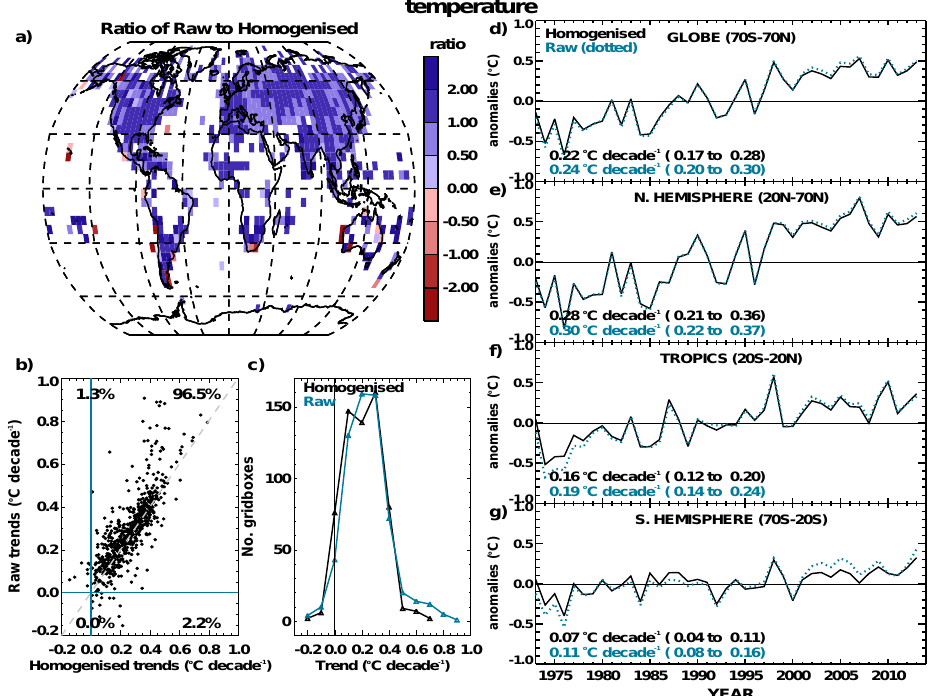
Figure 7. Comparison of decadal trends from 1973–2013 between raw and homogenised monthly mean temperature. (a) Ratio of raw to homogenised trends for each grid box (a value of > 1 means that the raw trend is greater than the homogenised trend). (b) Scatter plot of raw verses homogenised decadal trends for each grid box with percentage presence in each quadrant. (c) Trend size distribution for raw and homogenised grid boxes. (d) Large-scale area-average time series (weighted by the cosine of the latitude) and decadal trends calculated using the median of pairwise slopes with 5th to 95th percentile slopes as confidence